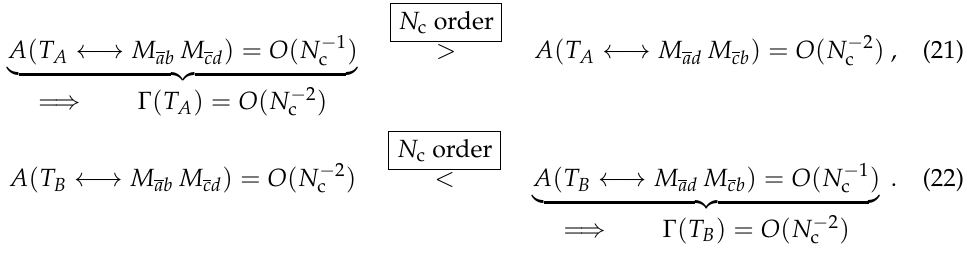
Table 3. Tetraquark total decay widths: expected upper bounds on large- N c behavior (from Ref. [20]).